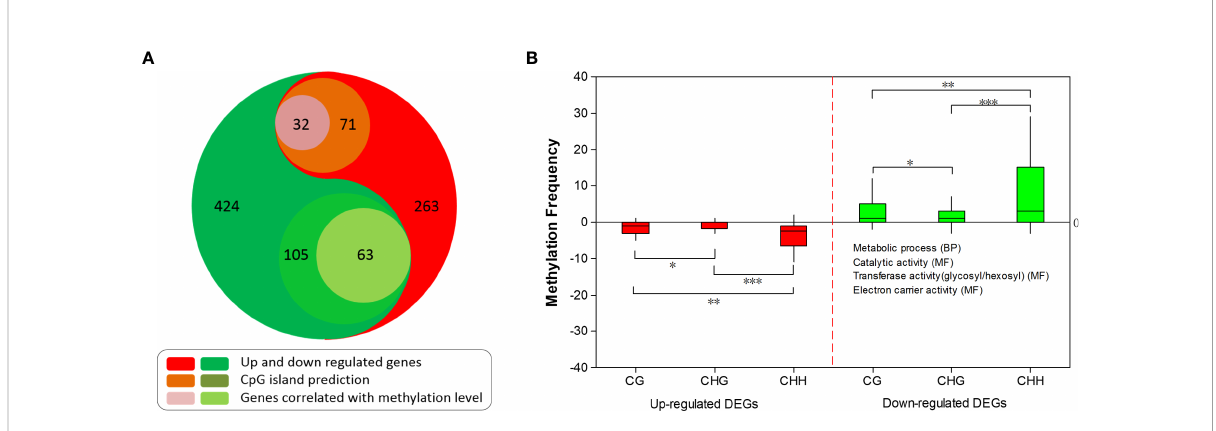
FIGURE 7 CGI prediction and correlation between methylation and expression of differentially expressed genes (DEGs). (A) Number of DEGs and DEGs with CGI prediction. (B) Methylation frequency of up-regulated and down-regulated DEGs. *, **, *** represents signi fi cant level of Student ’ s t- test of 0.05, 0.01, 0.001, respectively. Enriched GO categories of correlated DEGs are listed.